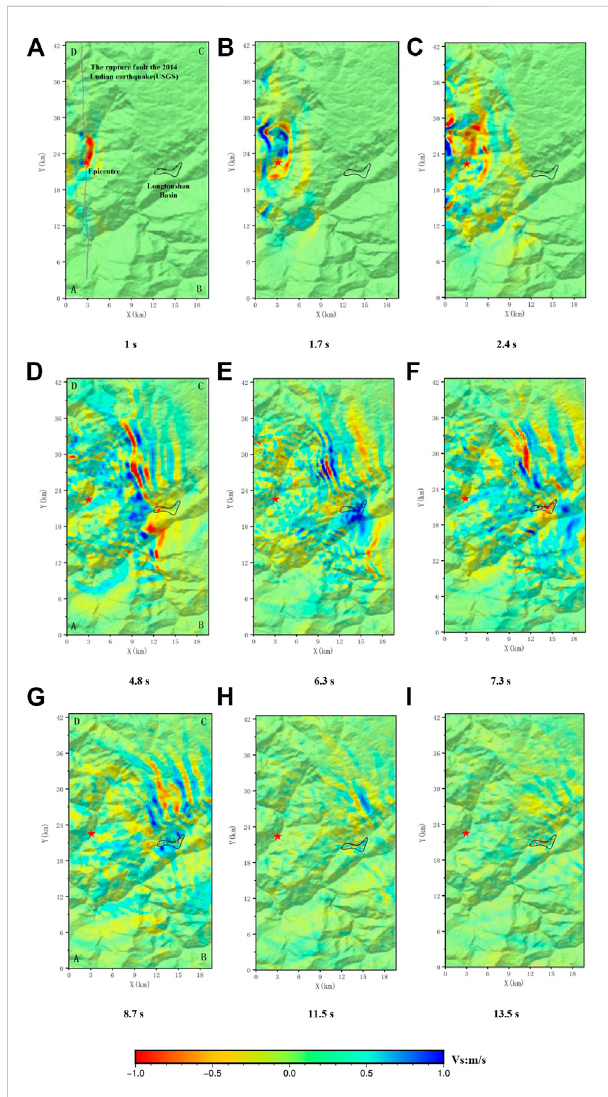
FIGURE 5 Wave fi eld snapshots of east – west components of the surface ground motion. The black outline denotes the basin. The red star and gray line denote the epicenter and rupture fault of this earthquake provided by the USGS, respectively. (A) 1 s; (B) 1.7 s; (C) 2.4 s; (D) 4.8 s; (E) 6.3 s; (F) 7.3 s; (G) 8.7 s; (H) 11.5 s; (I) 13.5